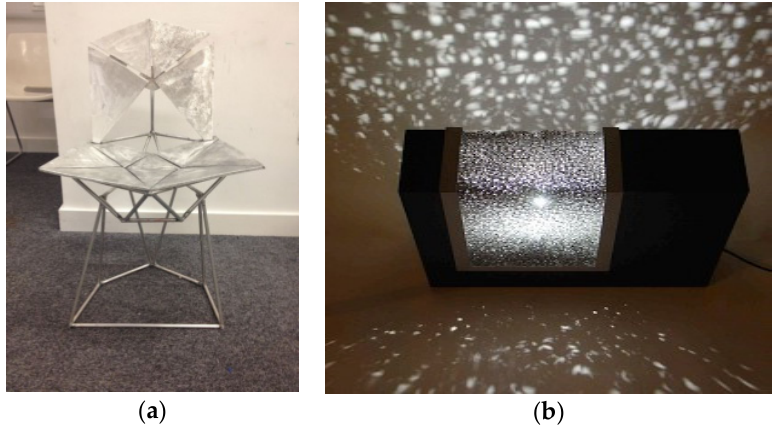
Figure 23. ( a ) Welded design chair made of Aluhab (courtesy of Norbert Babcsán, Aluinvent); and ( b ) art composition with metal swarm and light scattering effect from M ‐ pore (courtesy of Mayser).